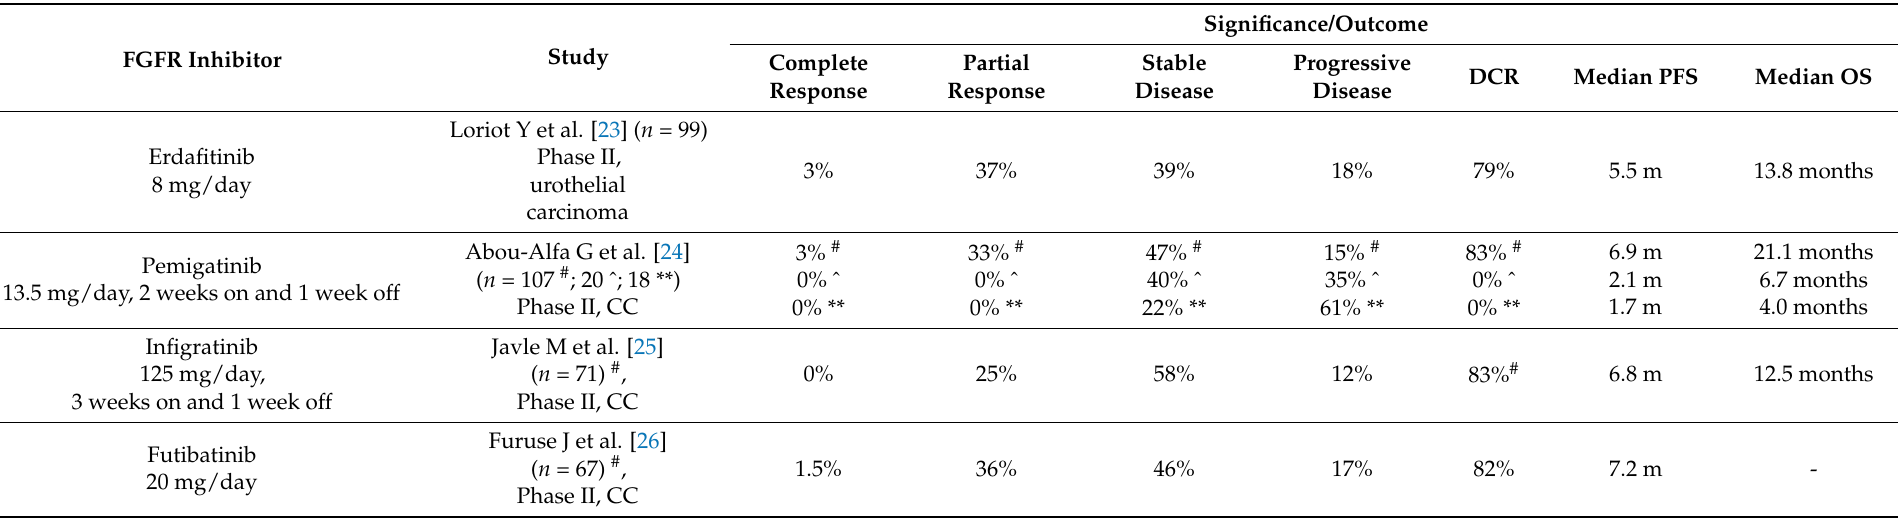
Table 2. Clinical efficacy of selected small-molecule tyrosine kinase inhibitors targeting the FGFR pathway.